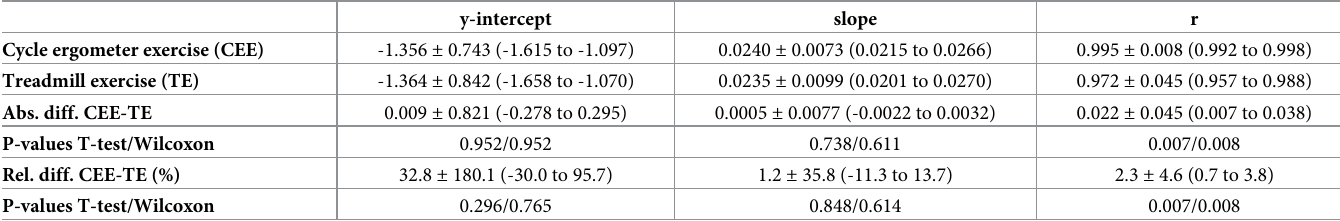
Table 4. Regression equations of model 1, and the absolute and relative exercise mode differences (n = 34, means ± SD, (95% CI) and P-values). y-intercept